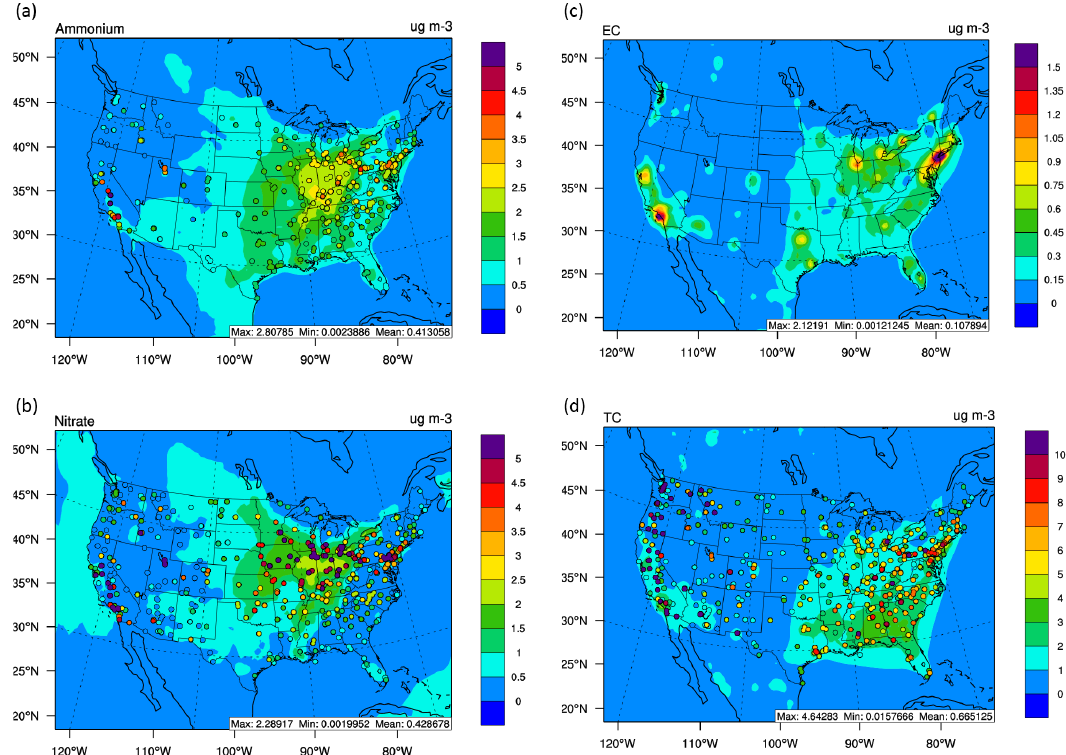
Figure 8. Spatial distribution of 10-year averaged hourly observed vs. simulated (a) ammonium, (b) nitrate, (c) EC, and (d) TC from STN and IMPROVE. The background plots represent the simulated data, while observations are represented by the